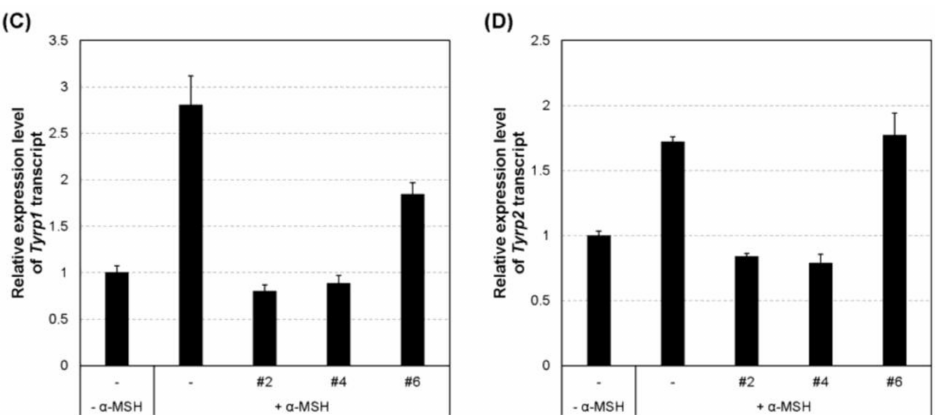
Figure 5. Relative mRNA transcript levels of melanogenic genes Mitf , Tyr , Tyrp1 , and Tryp2 . ( A ) Mitf mRNA level; ( B ) Tyr mRNA level; ( C ) Tyrp1 mRNA level; ( D ) Tyrp2 mRNA level. B16F10 cells were treated with one of three compounds ( #2 , #4 , and #6 ) at 2 µ M for 24 h. The relative mRNA levels for indicated genes in the cells were quantified using SYBR green-based real-time PCR and normalized to the β -actin mRNA level. The information of primer sets is shown in Table 1. α -MSH, α -melanocyte-stimulating hormone; Mitf , microphthalmia-associated transcription factor; Tyr , tyrosinase; Tyrp1 , tyrosinase-related protein 1; Tryp2 , tyrosinase-related protein 2.